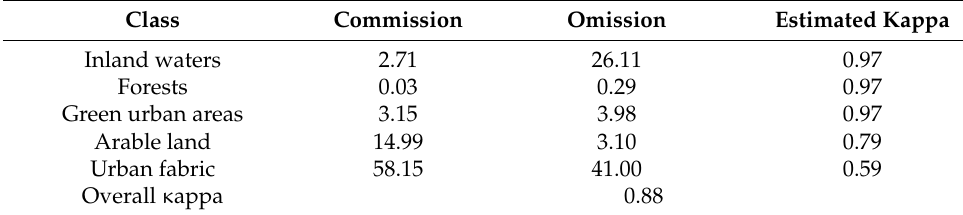
Figure 5. Random forest classification result [38] . Table 3. Random forest accuracy